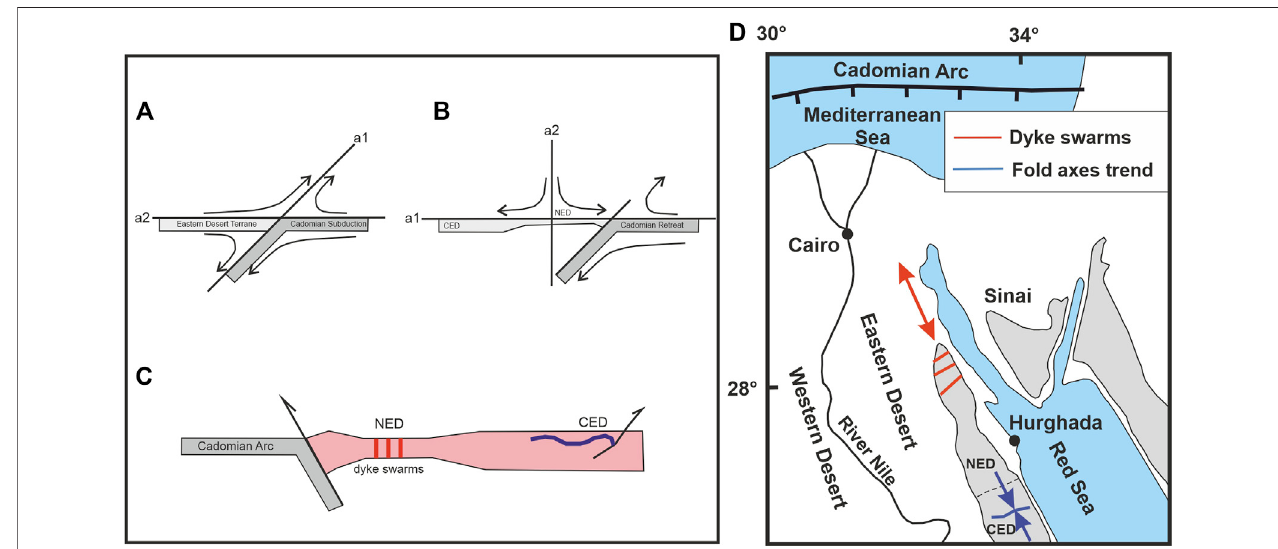
FIGURE15| Thirdfar- fi eldboundarycondition isconnectedwiththeformationand retreatoftheCadomianArc, (A) shows the fl ow fi eldduring initialarcformation and (B) fl ow fi eldduring arcretreat and thinningofNEDcrust. Astructuralsketchwith thinnedcrust and emplacementofdykeswarms and younger granitesisshown in (C) . Locally, compressional structures evolve in domains unaffected by crustal thinning. A sketch of map scale structures is given in (D) with domains of extension (red arrow) and compression (blue arrow).